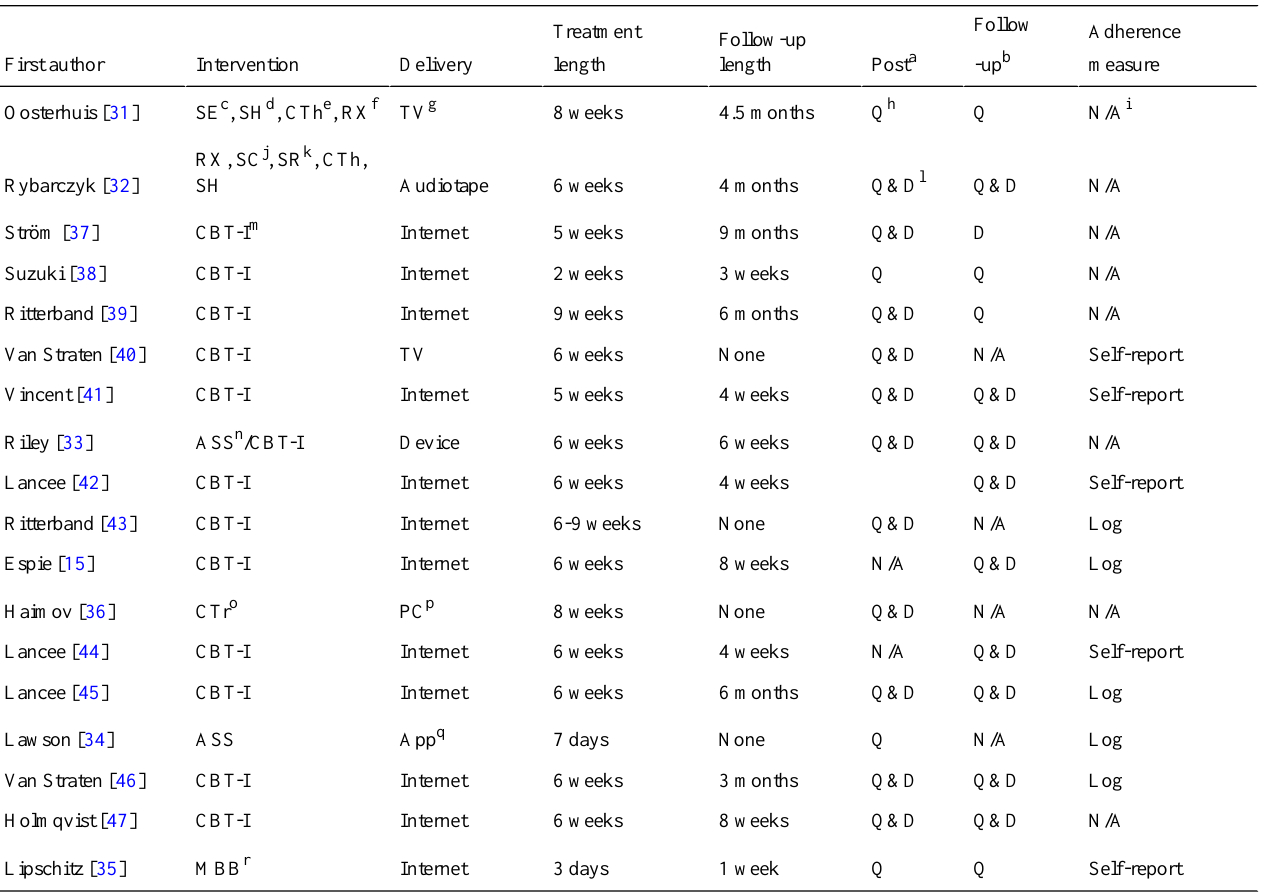
Table 2. Description of included studies.